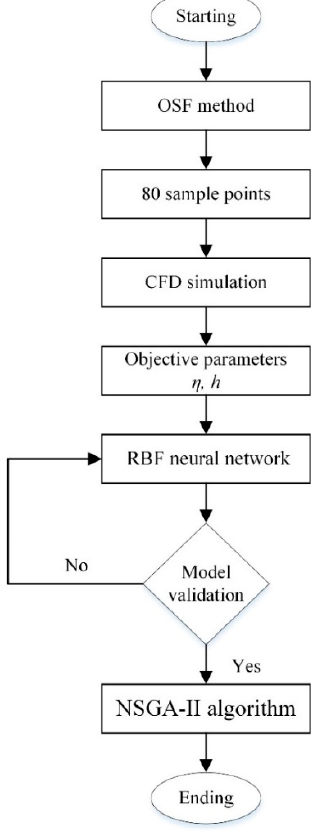
Figure 4. The optimization flow.